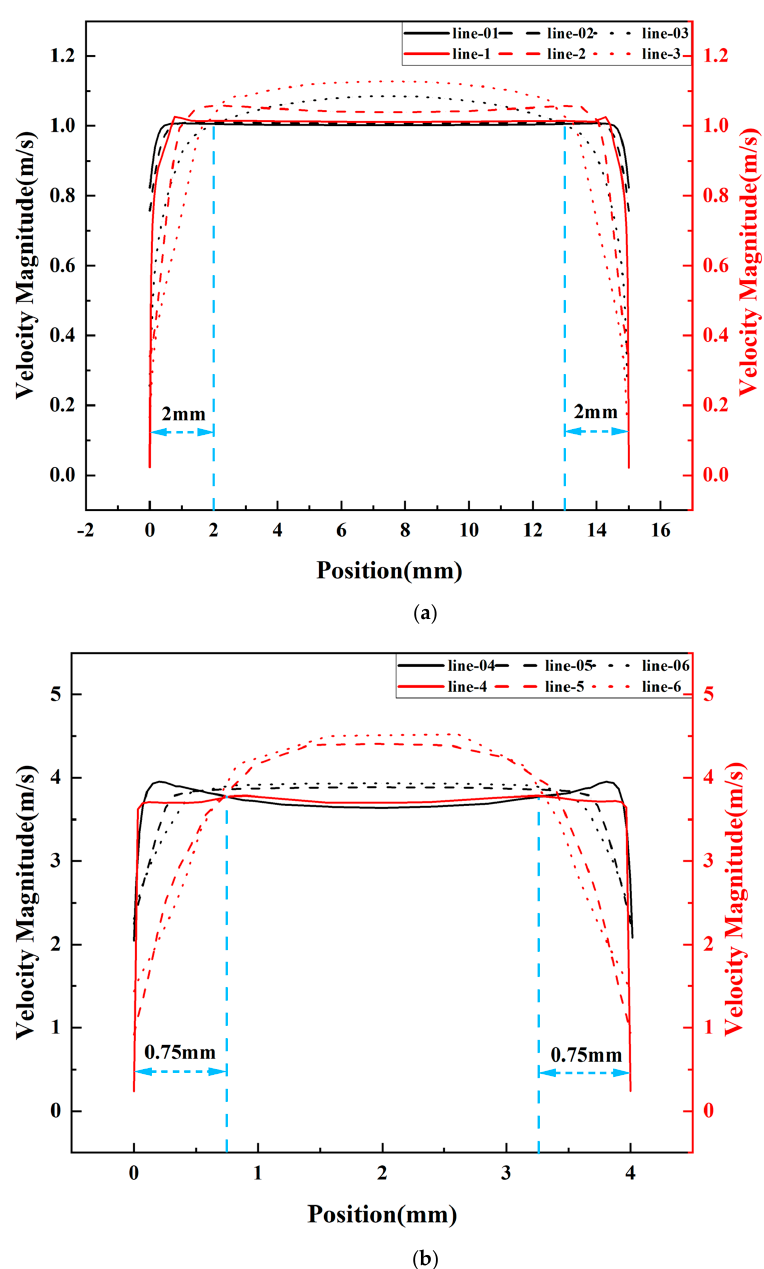
value of the velocity at each dividing line was extracted, and the curve of the change in the velocity at each dividing line with the distance of the dividing line was plotted. Line01/line1 to line06/line6 represent the positions shown in Figure 13.